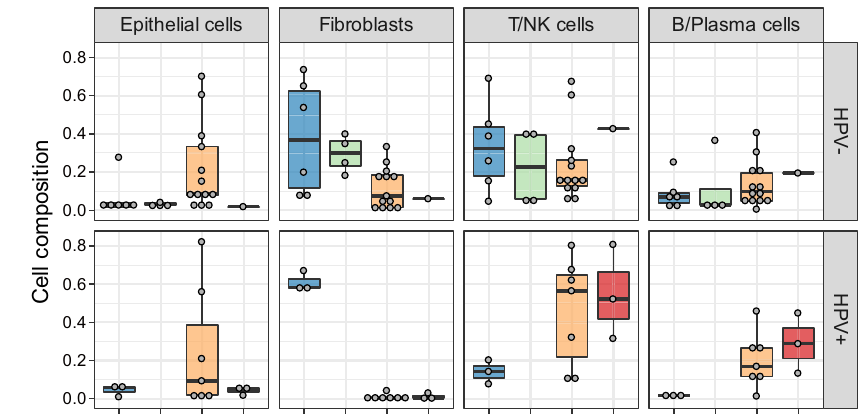
cells( n =7,437)areshownaccordingtothetissuetypesandpatients ’ HPVinfection status. Data pointsrepresent the averagevalueof thecell typeproportionsineach sample. Box plots show the median (center line), the upper and lower quantiles (box), and the range of the data (whiskers). Source data are provided in a Source Data fi